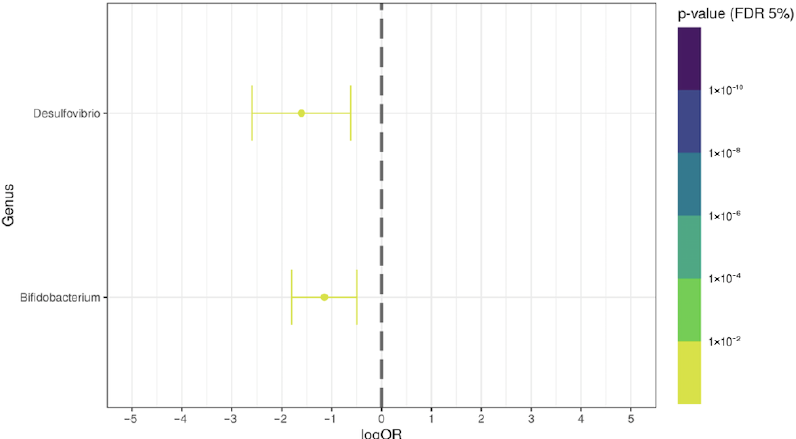
Figure 6. Differential genera relative abundance analysis of the intestinal microbiota in post-COVID-19+ATB group (N = 114), compared with post-COVID-19 group (N = 35).